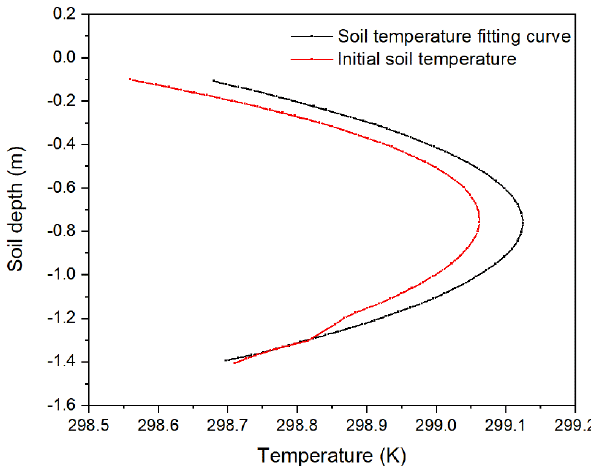
Figure 14. Fitting curve of initial soil temperature.